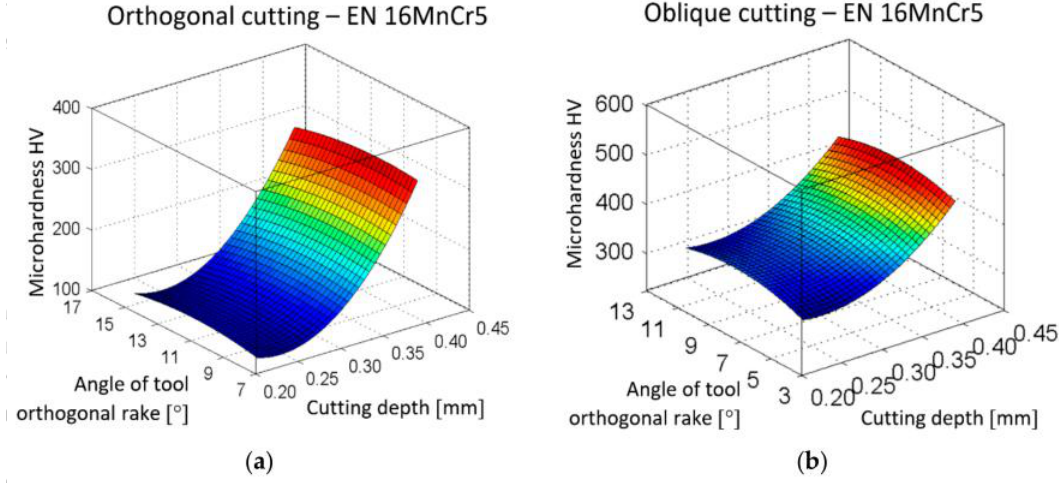
Figure 15. Dependency of microhardness HV on the cutting depth a p and on the orthogonal rake angle γ o . ( a ) Orthogonal cutting; ( b ) oblique cutting.